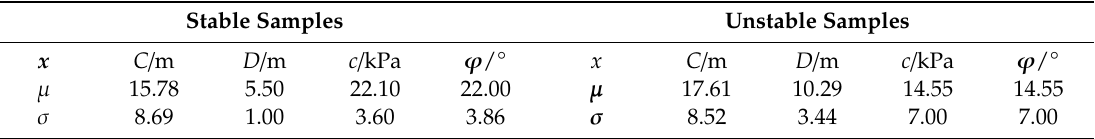
Table 2. Parameters associated with probability density function (PDF, the first classifier).